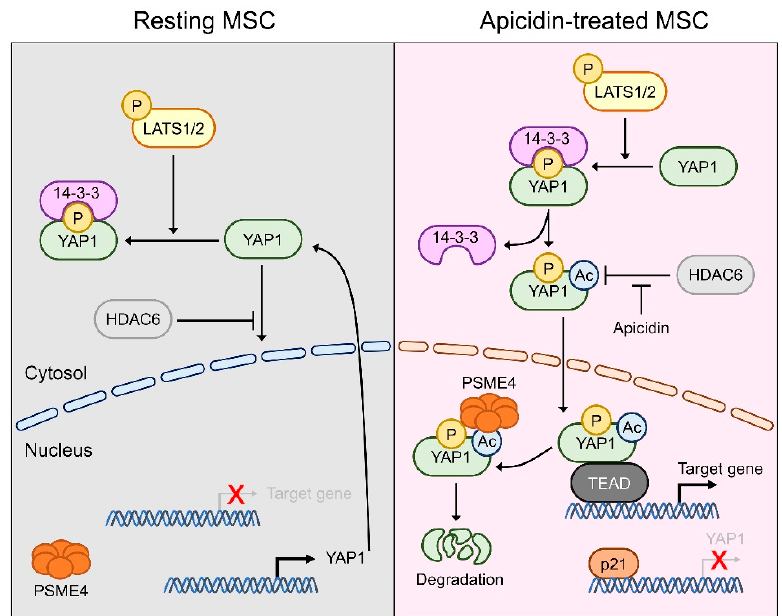
Figure 7. Working hypothesis. Hippo pathway in the resting MSC: LATS1/2 phosphorylated YAP1 S127. 14-3-3 recognizes phosphor-YAP1 and restricts YAP1 in the cytoplasm. HDAC6 indirectly interferes with nuclear translocalization of YAP1 ( left ). Acute regulation of YAP1 occurs under apicidin treatment. Apicidin blocks cytosolic HDAC6 and facilitates acetylation indirectly. Apicidin transactivates p21, which induces transcriptional arrest of YAP1. Acetylation of YAP1 dissociates YAP1 from 14-3-3 regardless of phosphorylation status. Acetylated-YAP1 is shuttled into the nucleus after being released from the cytosolic tethering molecule, 14-3-3. Nuclear YAP1 initiates target gene expression and recognition by PSME4, a subunit of the nuclear proteasome. PSME4 degrades acetyl-YAP1 in the nucleus ( right ).